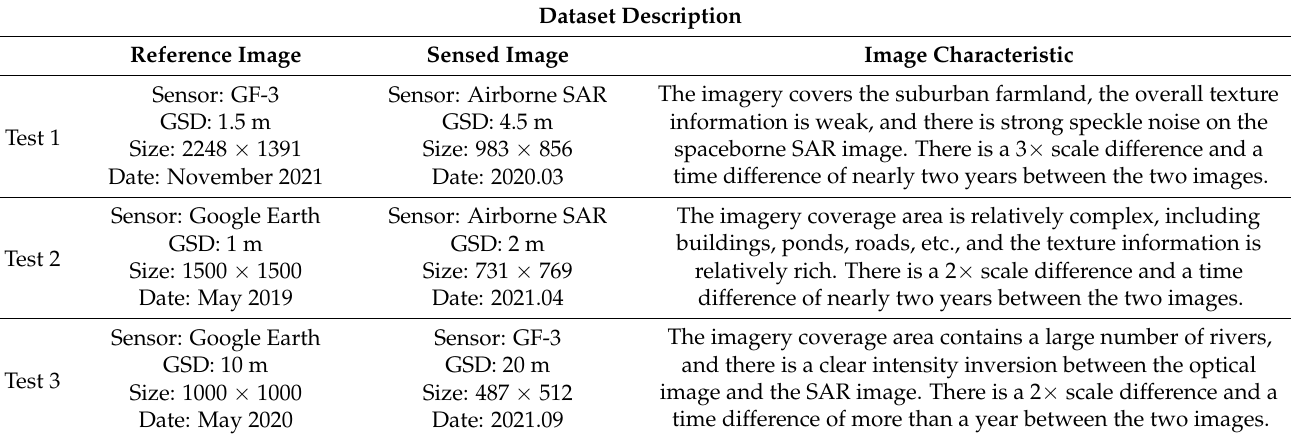
Table 5. Image registration experimental data.